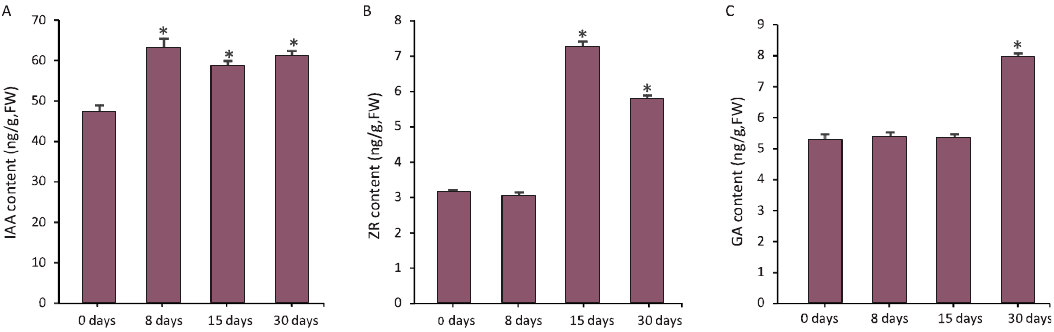
Figure 4. Determination of the contents of hormone at the graft unions during the pecan grafting process. ( A ) Indole acetic acid (IAA); ( B ) zeatin riboside (ZR); and ( C ) gibberellic acid (GA) at different timepoints. * indicates the significant differences ( p < 0.05) between the specific timepoints and the basal level (0 days).